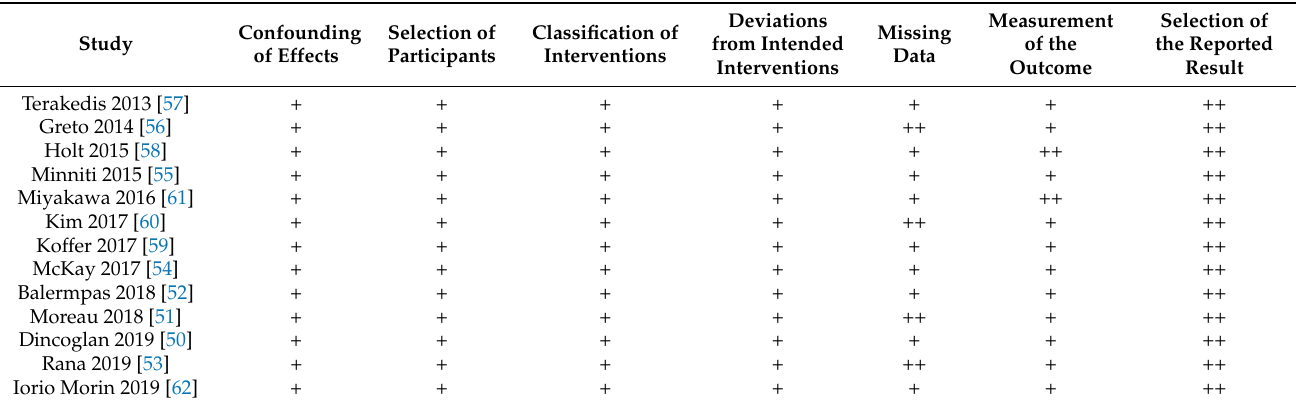
Table 1. Risk of